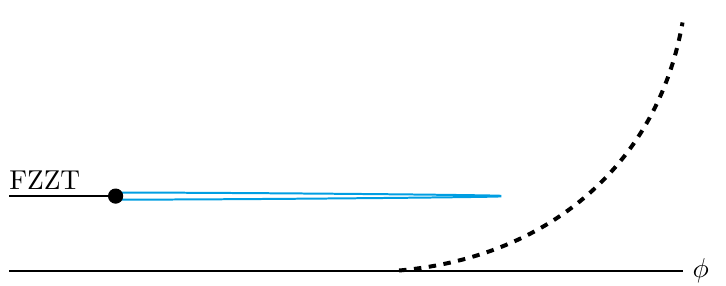
Figure 2 . A long string in c = 1 string theory is the high energy limit of an open string ending on an FZZT brane receding to the weak coupling